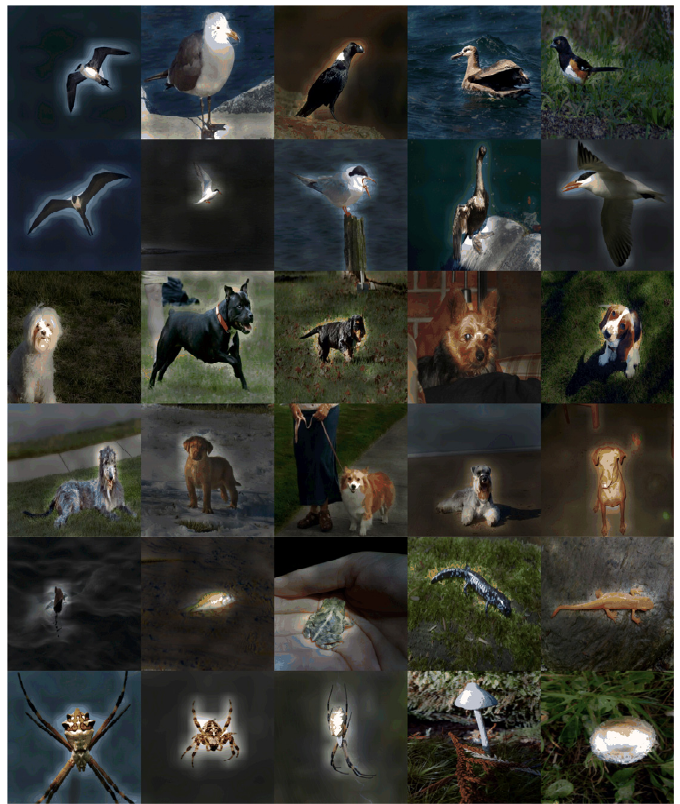
Figure 7. Visualization results of attention map.